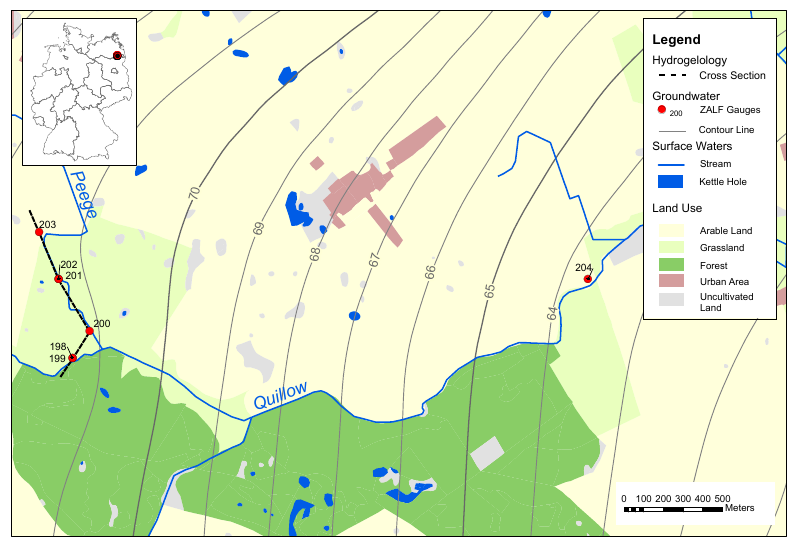
Figure 3. Location of the Quillow catchment and the site of ZALF’s installed and sampled groundwater observation wells; transect of the local geological profile indicated.